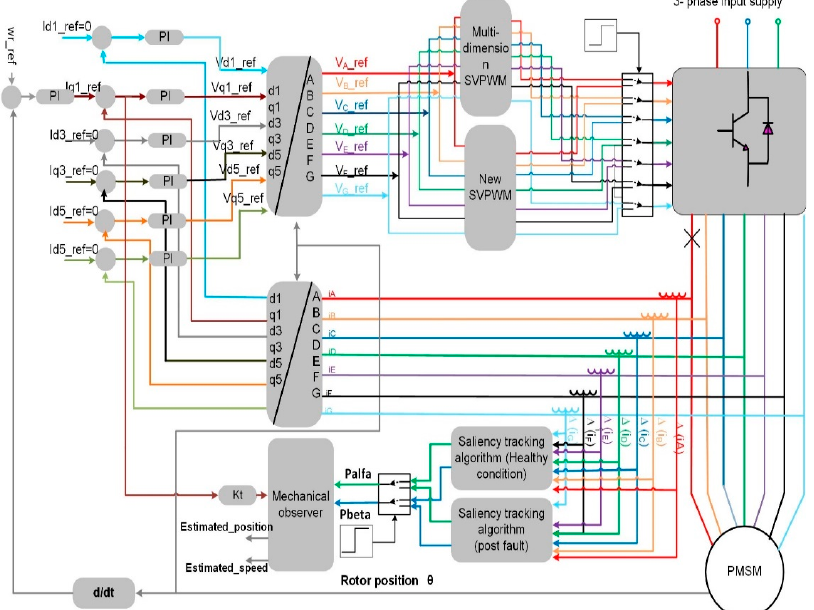
Figure 16. Control structure to obtain the saliency position in seven-phase drive after losing phase ‘A’. The simulation results obtained from this control structure are depicted in Figure 17.